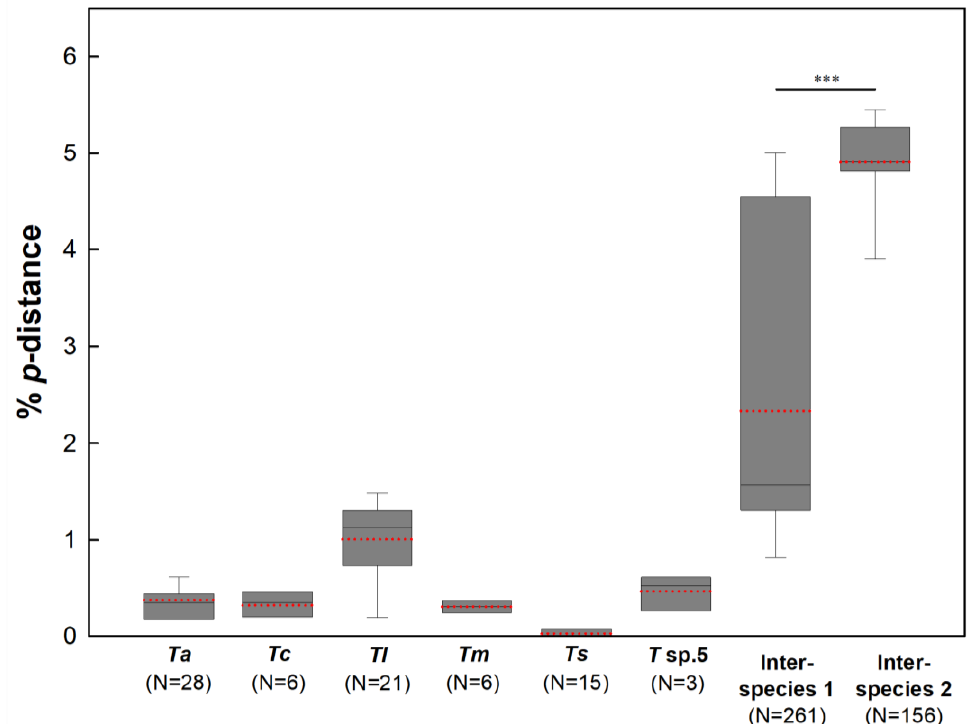
Figure 4. Nucleotide divergences of the genus Trichotorquatus 16S rRNA gene sequences (datasets used in Table S1) based on corrected pairwise genetic distance ( p -distance), including T . salinus . Genetic distances between each paired sequences were calculated by the Kimura 2-parameter model, where a total of six Trichotorquatus species (32 sequences) were compared. Bar heights indicate % p -distance measured for intra-species [e.g., T . andrei ( Ta ), T . coquimbo ( Tc ), T . ladouxae ( Tl ), T . maritimus ( Tm ), T . salinus ( Ts ), Trichotorquatus sp. 5 ( T sp.5)], inter-species 1 (e.g., Ta vs. Tc , Ta vs. Tl , Ta vs. Tm , Ta vs. T sp.5, Tc vs. Tl , Tc vs. Tm , Tc vs. T sp.5, Tl vs. Tm , Tl vs. T sp.5, Tm vs. T sp.5) and inter-species 2 ( Ta vs. Ts , Tc vs. Ts , Tl vs. Ts , Tm vs. Ts , Ts vs. T sp.5). The borders of the box show the first and third quartiles. The black solid and red dotted lines indicate the median and mean values, respectively ( t -test, *** p < 0.001).